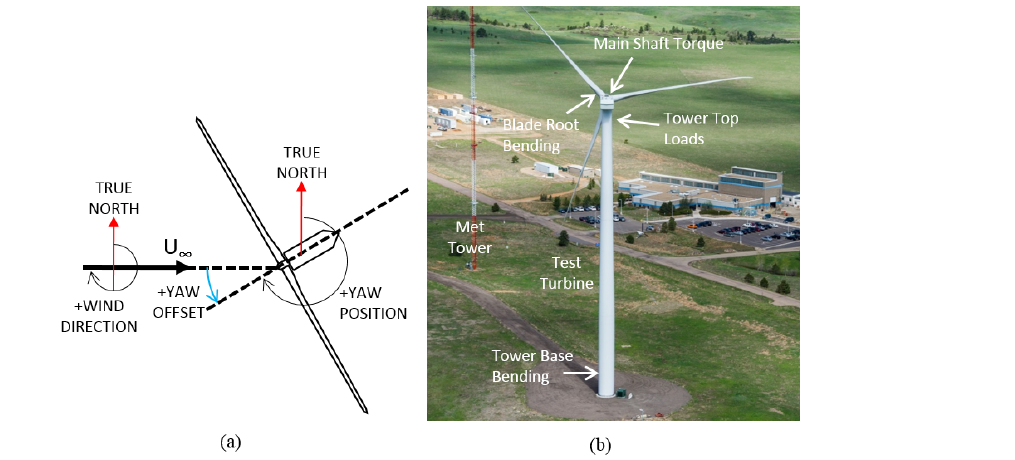
Figure 1. (a) Convention used in this paper for positive yaw and yaw offset. (b) View of the test turbine and meteorological tower, NREL 25911.